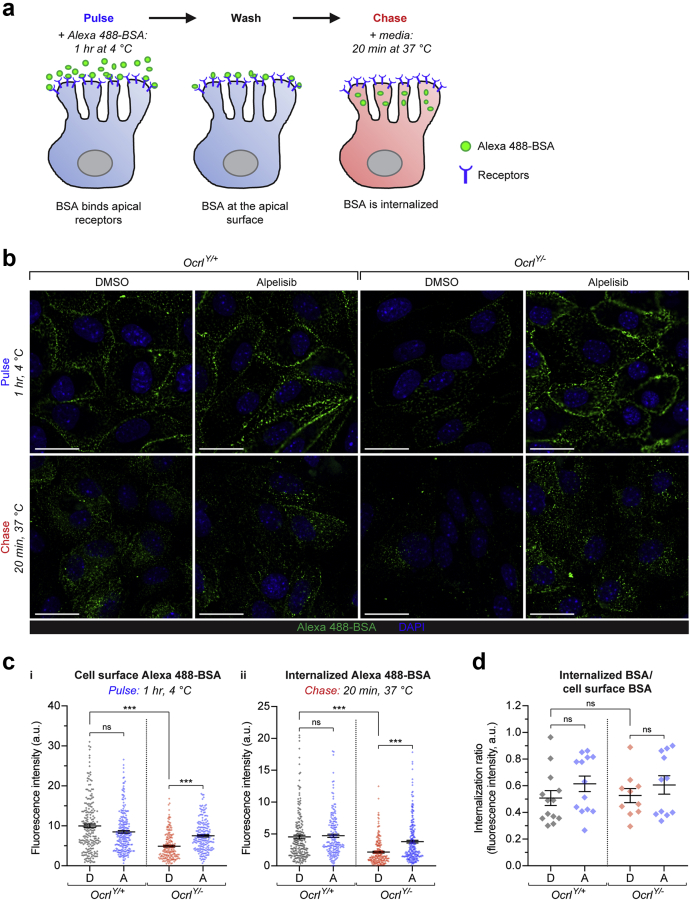
Alpelisib improves endocytic uptake of humanized OcrlY/−mouse PTCs (mPTCs). (a) Schematic illustrating the pulse-chase experiment used to examine the binding and internalization of Alexa 488-bovine serum albumin (BSA) into mPTCs. Cells were exposed to Alexa 488-BSA (0.2 mg/ml) for 1 hour at 4 °C to allow BSA to bind to cell surface receptors (pulse) and then warmed to 37 °C in cell medium for 20 minutes before fixation to allow ligand internalization (chase). (b) Representative confocal micrographs of OcrlY/+ or OcrlY/− mPTCs treated with dimethylsulfoxide (DMSO) or 10 μM of alpelisib for 16 hours and subjected to the Alexa 488-BSA (green) pulse-chase experiment, before being fixed and labeled for 4′,6-diamidino-2-phenylindole (DAPI) (blue). The pulse phase of the experiment is shown in the top panel for each condition, with the chase below. Bars = 20 μm. (c) Quantification of cell surface Alexa 488-BSA (i) and internalized Alexa 488-BSA (ii), evaluated as mean fluorescence intensities per cell. Alpelisib rescues the rescued BSA binding and internalization observed in OcrlY/−cells. N = 209, 228, 186, and 196 cells for OcrlY/+ DMSO, OcrlY/+ alpelisib, OcrlY/− DMSO, and OcrlY/− alpelisib conditions, respectively in (i) and N = 203, 183, 199, and 233 cells for OcrlY/+ DMSO, OcrlY/+ alpelisib, OcrlY/− DMSO, and OcrlY/− alpelisib conditions, respectively in (ii), in each case pooled from 2 mouse kidneys per condition; each data point represents the mean fluorescence intensity in an individual cell. Significance was tested by Kruskal-Wallis (K-W) analysis of variance (ANOVA) with Dunn’s multiple comparisons test: for (i) cell surface BSA, overall ∗∗∗P < 0.001, multiple comparisons: OcrlY/+ DMSO versus OcrlY/− DMSO and OcrlY/− DMSO versus OcrlY/− alpelisib ∗∗∗P < 0.001; OcrlY/+ DMSO versus OcrlY/+ alpelisib P = 0.60 (not significant [ns]); for (ii) internalized BSA, overall ∗∗∗P < 0.001, multiple comparisons: OcrlY/+ DMSO versus OcrlY/− DMSO and OcrlY/− DMSO versus OcrlY/− alpelisib ∗∗∗P < 0.001; OcrlY/+ DMSO versus OcrlY/+ alpelisib P = 0.66 (ns). (d) Quantification of the ratio between the cell surface Alexa 488-BSA and the internalized Alexa 488–BSA fluorescence intensities, showing no significant differences in ratios between each condition. Each point represents the average of the ratio in a field containing approximately 15–20 cells (N = 13, 13, 10, and 11 randomly selected fields for OcrlY/+ DMSO, OcrlY/+ alpelisib, OcrlY/− DMSO, and OcrlY/− alpelisib conditions, respectively, in each case pooled from 2 mouse kidneys per condition). Significance was tested by K-W ANOVA with Dunn’s multiple comparisons test: overall P = 0.46 (ns), multiple comparisons: OcrlY/+ DMSO versus OcrlY/− DMSO and OcrlY/− DMSO versus OcrlY/− alpelisib P > 0.99 (ns); OcrlY/+ DMSO versus OcrlY/+ alpelisib P = 0.84 (ns). To optimize viewing of this image, please see the online version of this article at www.kidney-international.org.